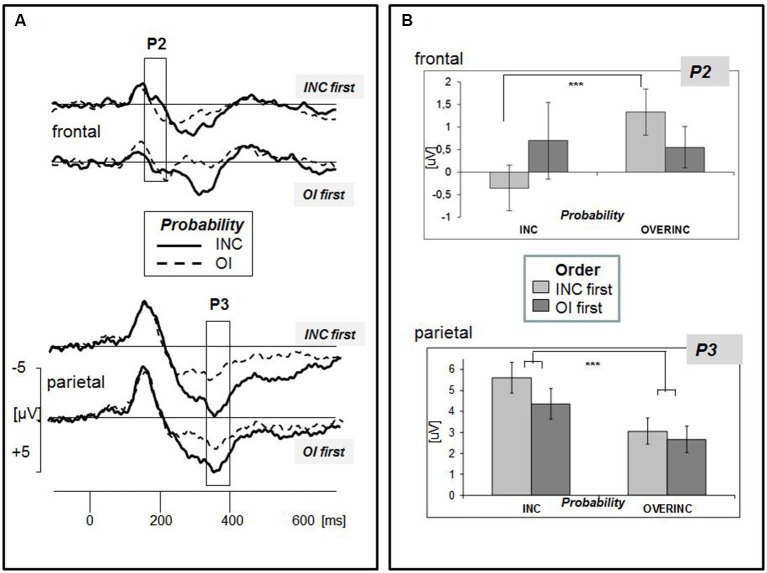
(A) Grand-averaged ERPs for the event “ball possession of the participant” separated for the two experimental groups (order of condition: “INC first” vs. “OI first”). Electrodes are pooled to the clusters “frontal” and “parietal”. Two experimental conditions related to different probabilities of ball possession are superimposed (INC: inclusion, 33%; OI: overinclusion, 46%). Amplitude differences between the conditions were observed in two time windows, 150–210 ms (P2, see frontal leads) and 320–400 ms (P3, see parietal leads). (B) Mean ERP amplitudes of the two components separated for the effect of experimental condition “probability” (inclusion vs. overinclusion) and “order of conditions” (inclusion first vs. overinclusion first). Bars indicate the standard error of mean.